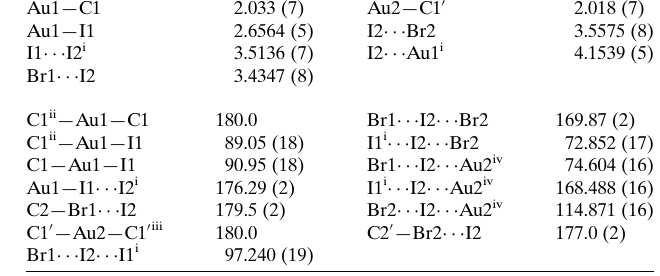
Figure 2 Structure of the asymmetric unit of compound 3 ; ellipsoids represent 50% probability levels. The dashed line indicates a halogen bond.